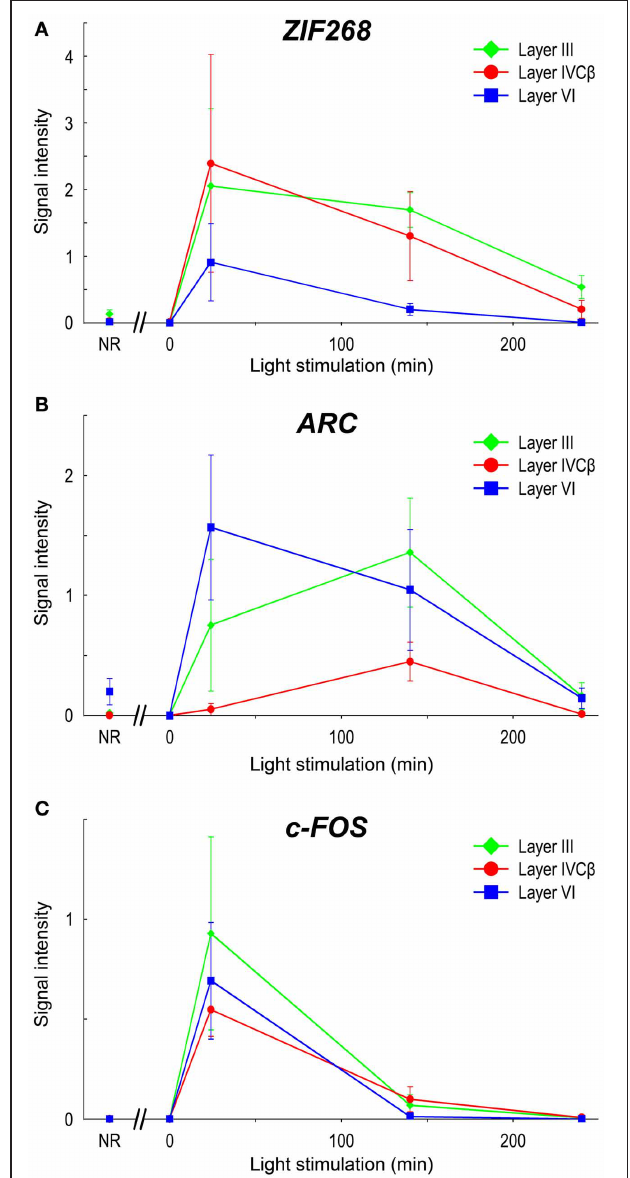
FIGURE 6 | mRNA levels of IEGs in marmoset V1 induced by monocular light stimulation. Signal intensities of ISH of IEGs in layers III, IVC β , and VI in V1 are shown: (A) ZIF268 , (B) ARC , and (C) c-FOS . To quantify laminar distribution, signal intensities of ISH were calculated under each stimulus time in each layer (or sublayer) (see “Materials and Methods” for details). NR: mRNA levels in V1 of NR marmosets. For this calculation, five or six sections were obtained from two or three marmosets in each time point (see Table 1 ). The plots for different layers are indicated by colors (green: layer III; red: layer IVC β ; blue: layer VI). Error bars show